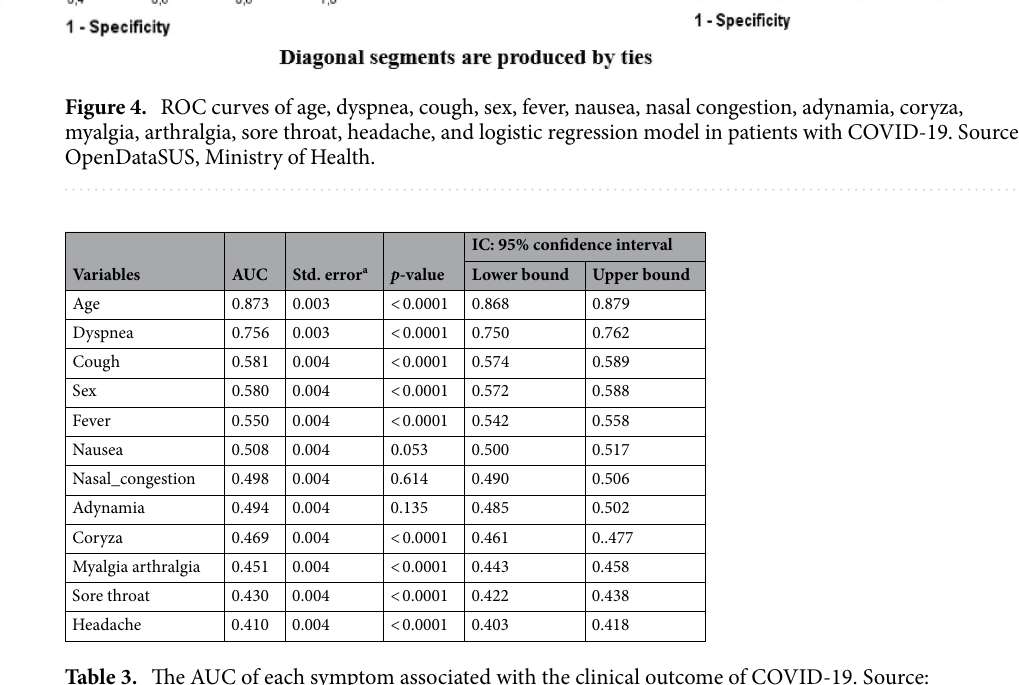
Table 3. The AUC of each symptom associated with the clinical outcome of COVID-19. Source: OpenDataSUS, Ministry of Health.